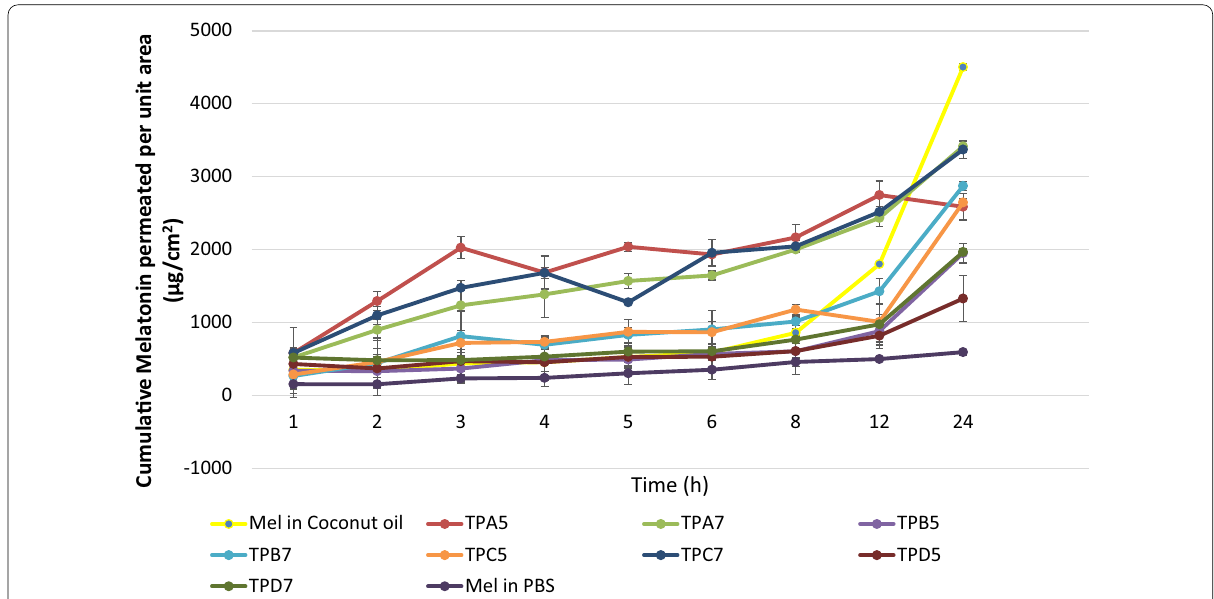
Fig. 2 Melatonin permeation profiles from different optimized ME formulae in PBS (pH 7.4, 37 °C